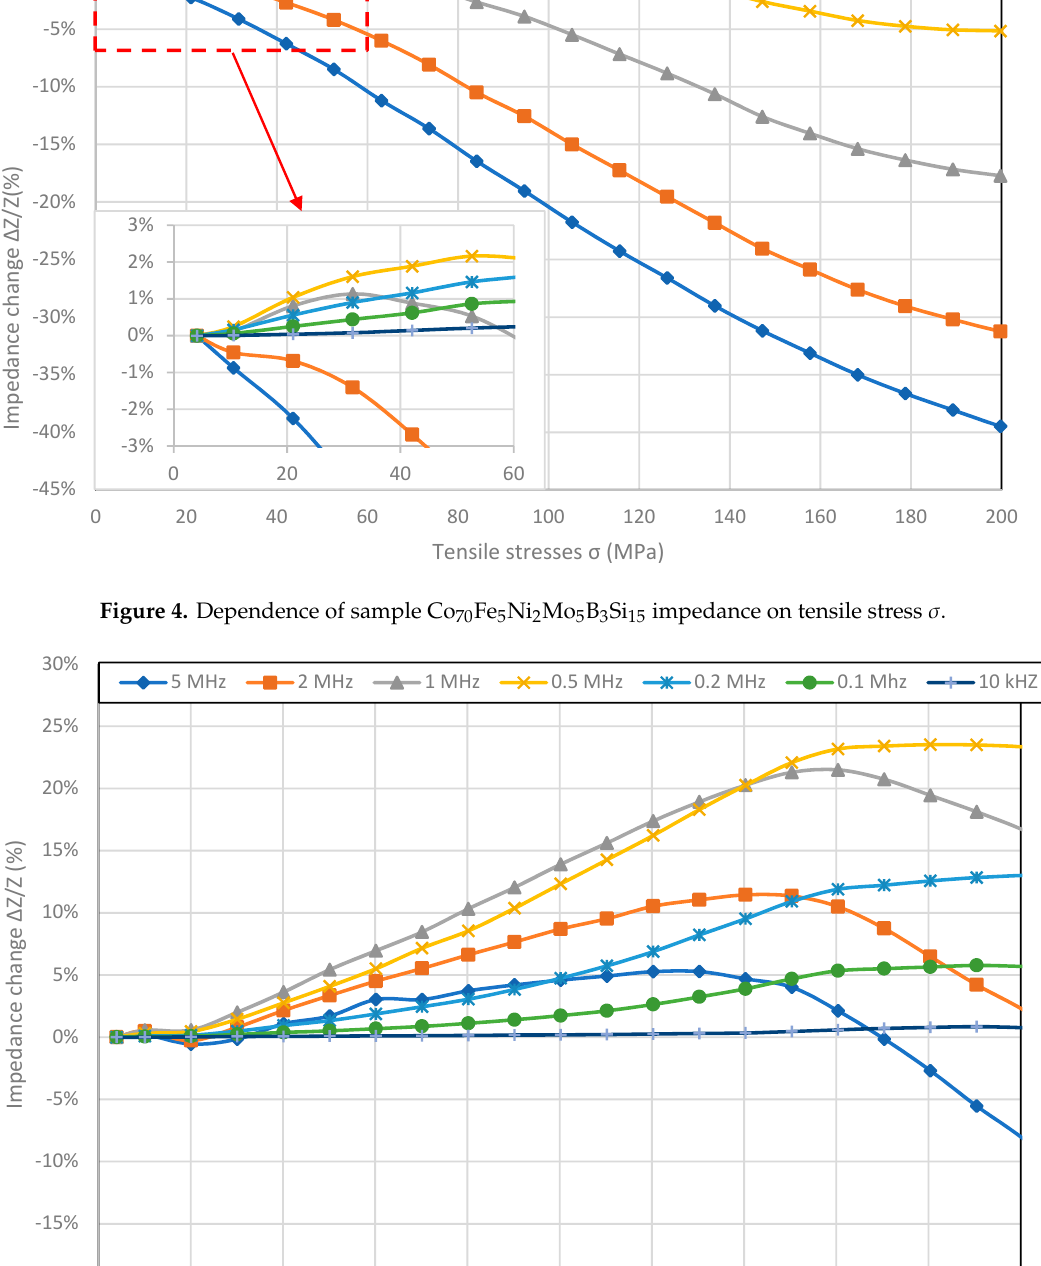
Figure 5. Dependence of sample Co 84 Fe 1.5 Mo 2 Mn 1.5 Si 7 B 2 impedance on tensile stress σ .